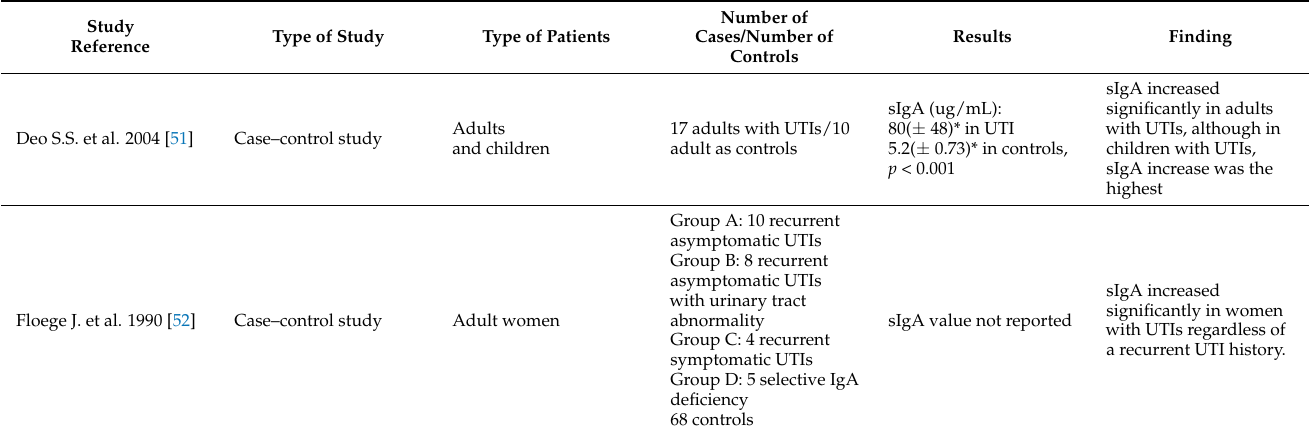
Table 7. Urine sIgA diagnostic value in UTIs; target population: adults.